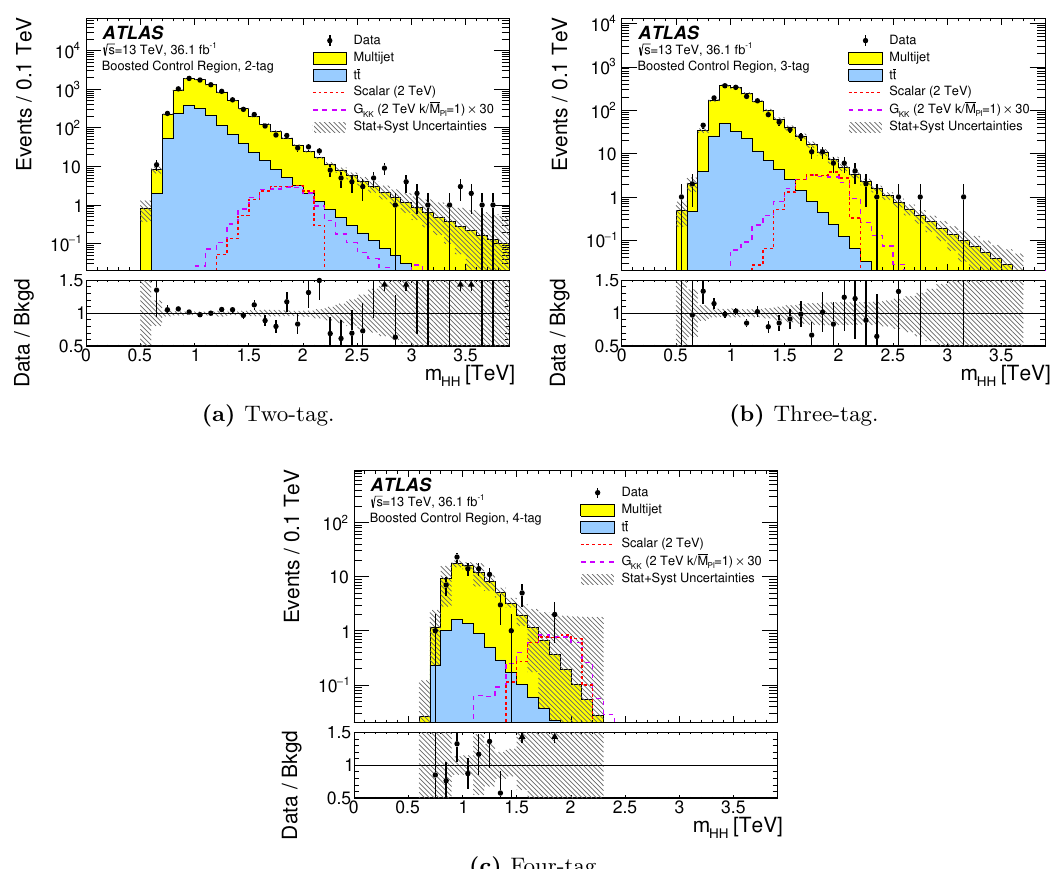
Figure 7. The m 2J distributions in the control region of the boosted analysis for the data and the predicted background (top panels) for (a) the two-tag, (b) the three-tag, and (c) the four-tag samples. The data-to-background ratio (bottom panels) shows also the combination of statistical and systematic uncertainties as the grey hatched band. The expected signal for a 2 TeV G KK resonance with k=M Pl = 1 and a scalar with the same mass is also shown. The scalar has an arbitrary cross section times branching ratio of 12